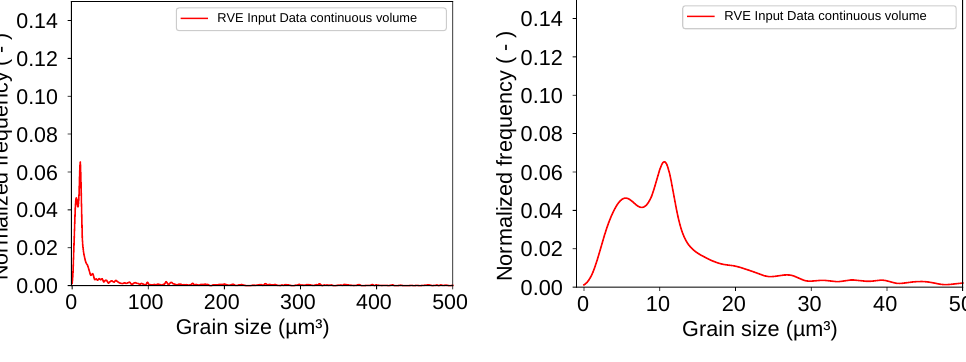
Figure 6. Log probability density of grain volumes shows that most grain volumes are in the range between 0 µ m 3 and 50 µ m 3